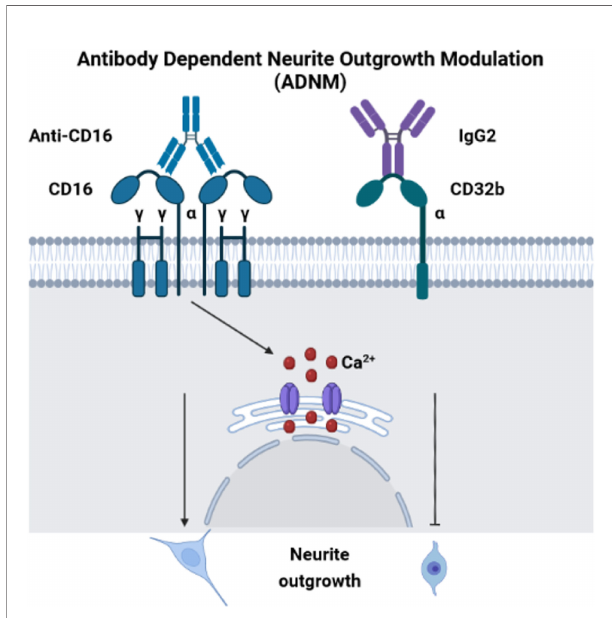
FIGURE 8 | Antibody dependent neurite outgrowth modulation (ADNM). CD16 activation with anti-CD16 induces calcium release from RE and triggers neurite outgrowth. On the contrary, C32b activation by IgG2 isotype prevents CD16 from triggering neurite